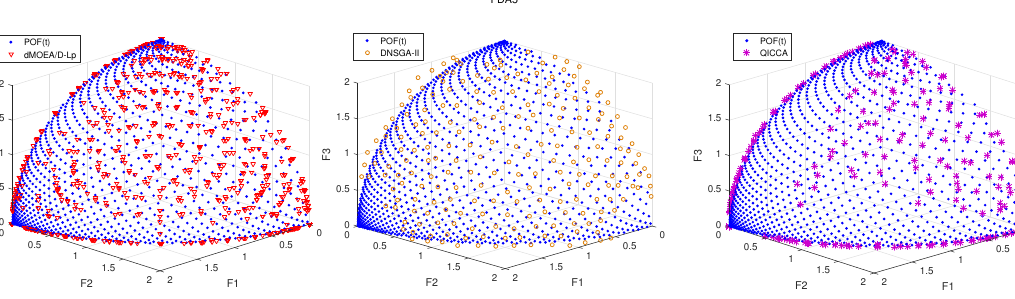
Figure 10. Solution sets obtained by three algorithms at t = 13.2 on FDA5 in case of τ T = 15, n T = 5. The POS ( t ) and POF ( t ) of FDA4 were similar to FDA5, except that the spherical radius of the POF ( t ) remained the same value (one), not varying with time t . Similar comparing results